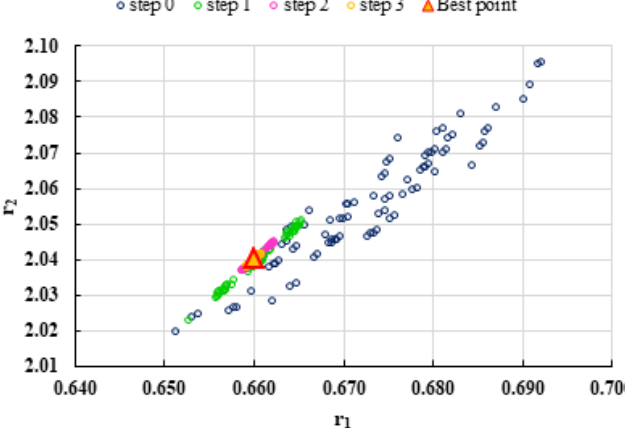
Figure 6. Distribution of P cen (r 1 , r 2 ) points for each step of searching for the k-NN method for the conditions imposed by MC3.